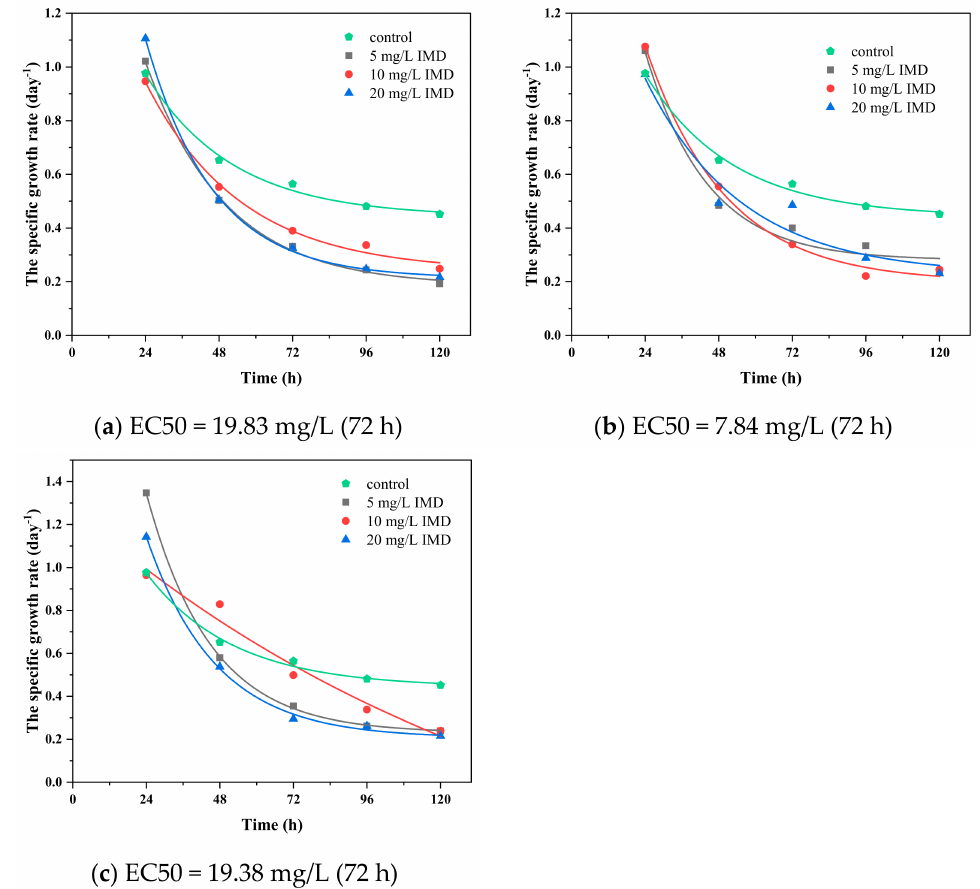
Figure 9. Growth curves of Chlorella vulgaris with different concentrations of IMD (5, 10, and 20 mg/L) when TiO 2 had a constant value 150 mg/L ( a ), 300 mg/L ( b ), and 600 mg/L ( c